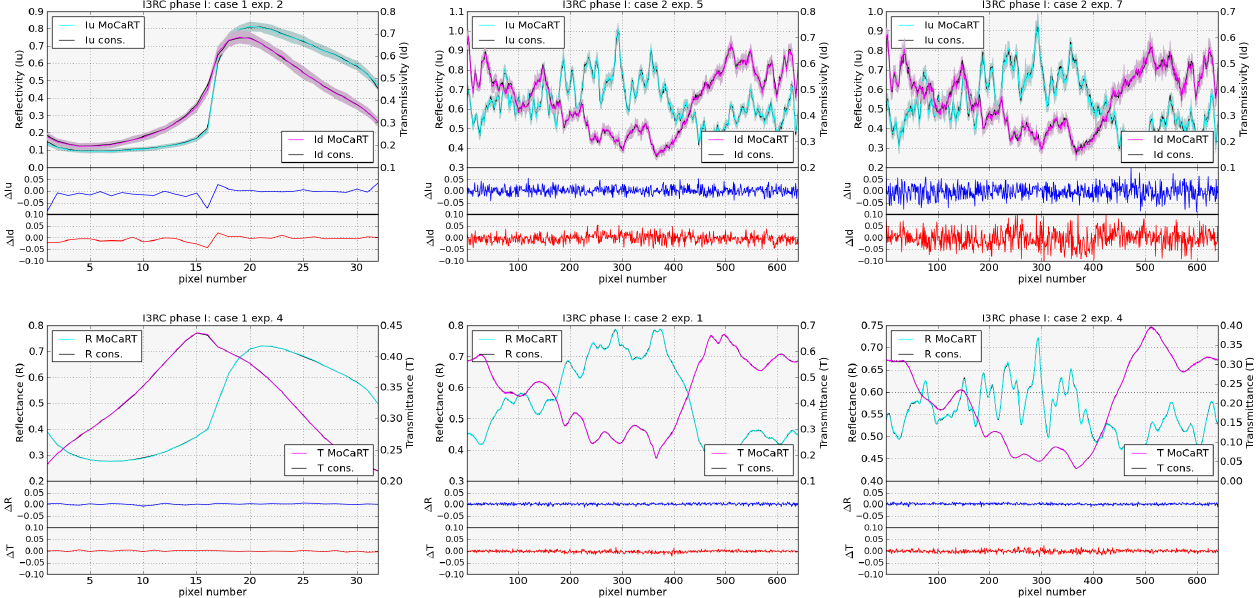
Fig. 1. I3RC project phase I. Case 1 represents a step cloud of mean optical thickness of 10. Case 2 represents a measured 2-D cloud field. MoCaRT results are compared to the consensus results of the participants in the I3RC project. The upper row presents radiance results (reflectivities and transmissivities), whereas the lower row presents flux densities (reflectances and transmittances). The left column illustrates results of the case 1 and the central and right column of case 2. The central (lower) panel of all subplots illustrates the reflectivity/reflectance (transmissivity/transmittance) relative difference. The local discrepancies are few percent for all cases, except for the transmissivity of experiment 7 of case 2, where the discrepancies exceed 5% in some regions. All cases are well within the error bars as illustrated in upper